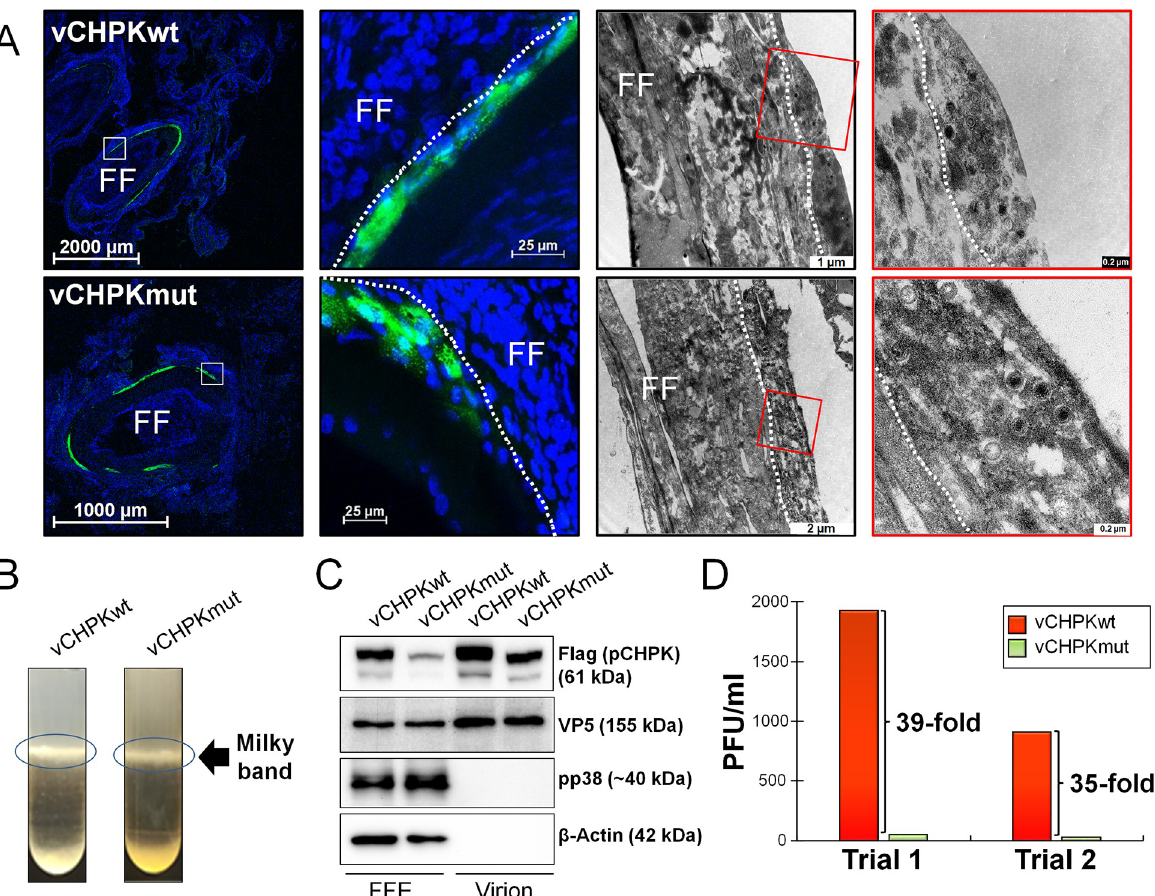
Fig 1. CHPK is required for efficient infection. (A) Infected FFE skin cells were isolated using fluorescent protein expression to identify vCHPKwt and vCHPKmut-infected cells. TEM was used to examine viral particles in representative skin epithelial cells of vCHPKwt- and vCHPKmut-infected cells. Regions highlighted in red were blown up to better visualize viral particles. White dotted lines were used to delineate the epithelial skin layer (FFE cells). (B) Viral particles were purified from the infected skins of three birds per group, combined, and the “milky band” containing enveloped viral particles was isolated for both groups. (C and D) Purified viruses from (B) were used for immunoblotting (C) and infectivity assays (D) on CKCs, and plaques were counted 5 days pi in two